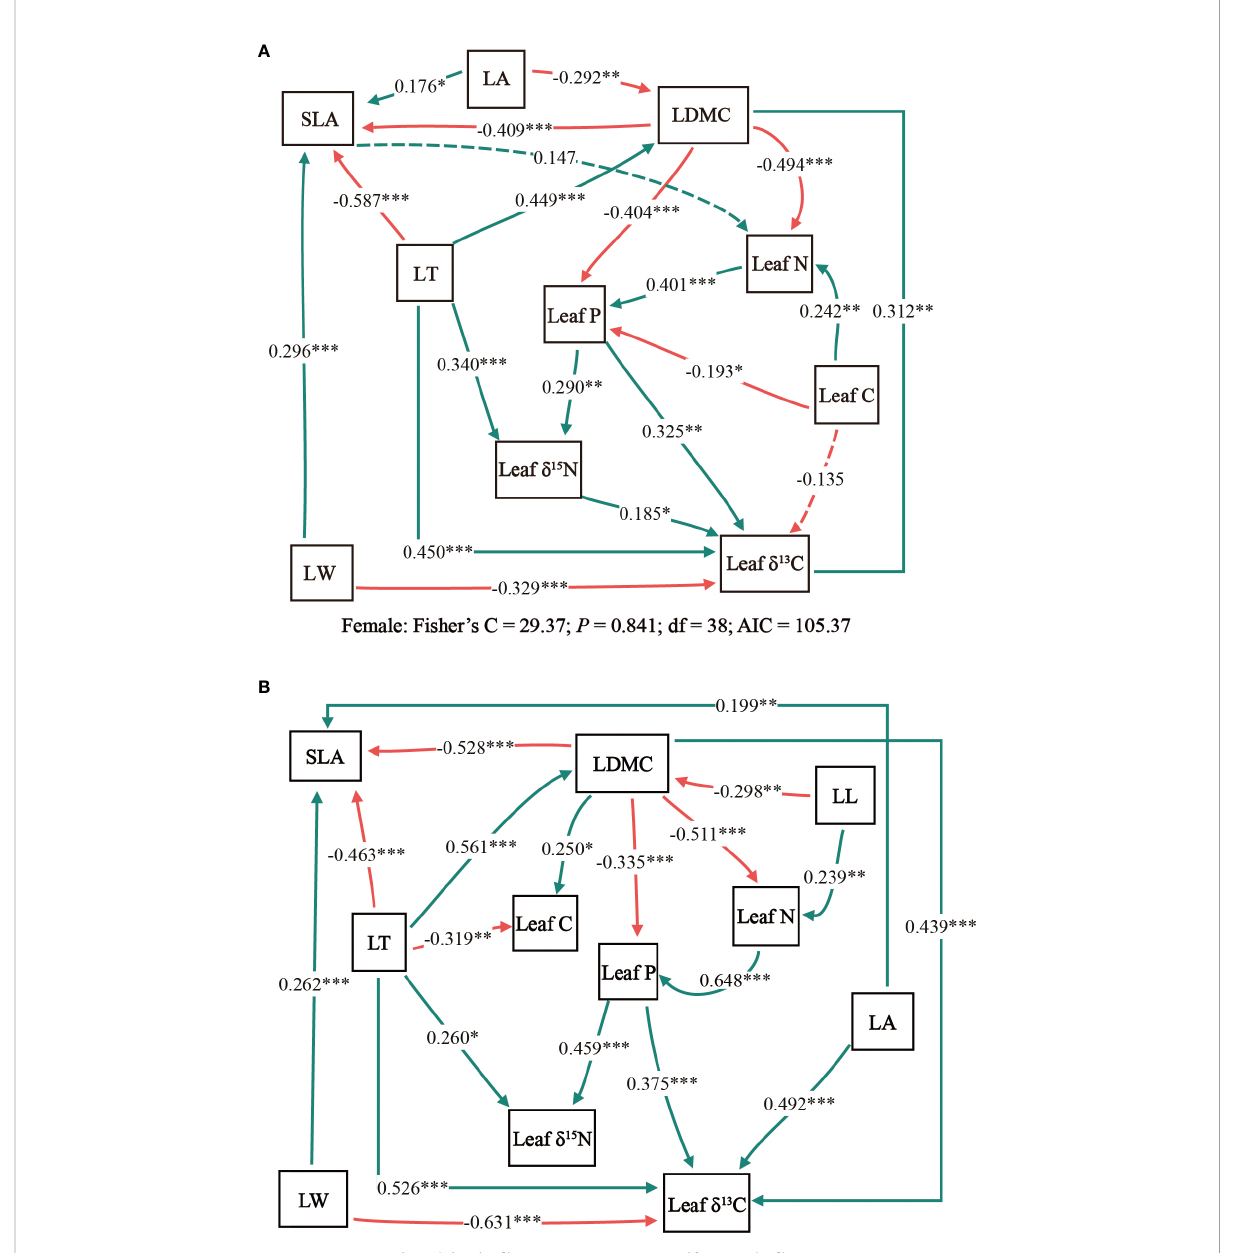
FIGURE 3 The piecewise structural equation models for testing the interrelations of leaf traits in female (A) and male (B) T. fuana . Solid arrows represent signi fi cant paths ( P < 0.05) and dashed arrows represent non-signi fi cant paths ( P > 0.05). The red arrows re fl ect negative relationships and the green arrows re fl ect positive relationships. Each path coef fi cient was standardized. *, **, *** indicated P < 0.05, P < 0.01, P < 0.001, respectively. LT, leaf thickness; LL, leaf length; LW, leaf width; LA, leaf area; SLA, speci fi c leaf area; LDMC, leaf dry matter content; Leaf C, leaf carbon content; Leaf N, leaf nitrogen content; Leaf P, leaf phosphorus content; Leaf d 13 C, leaf carbon isotope ratio; Leaf d 15 N, leaf nitrogen isotope